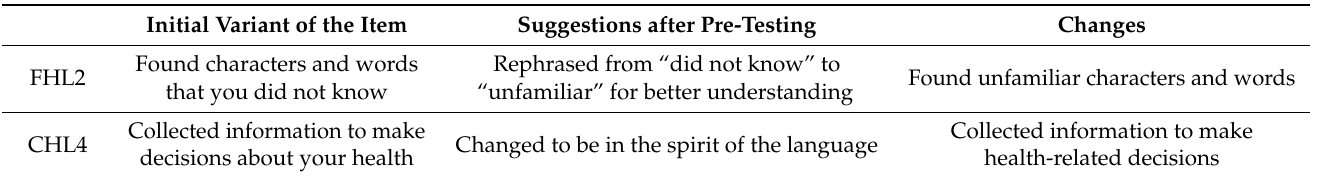
Table 2. Linguistic adaptation of the items from the FCCHL-SR14 instrument included in the discussion after pre-testing.